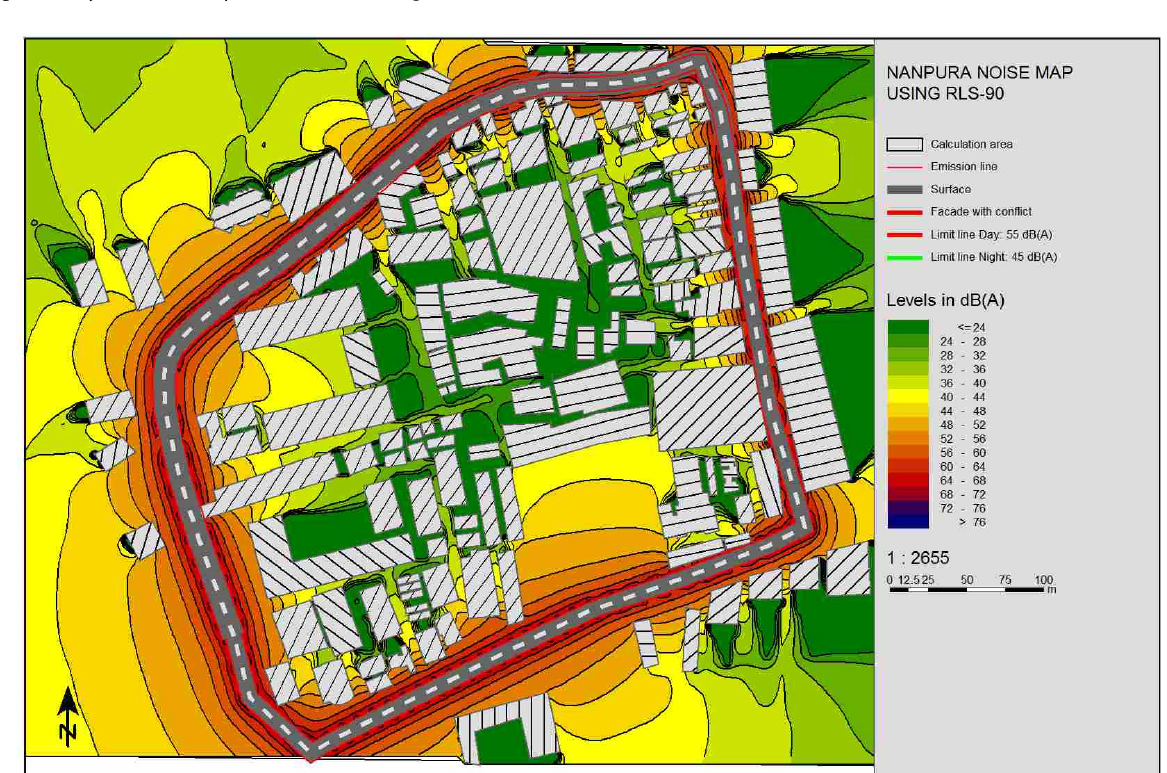
Figure 7: Day time noise map of Central zone using RLS-90